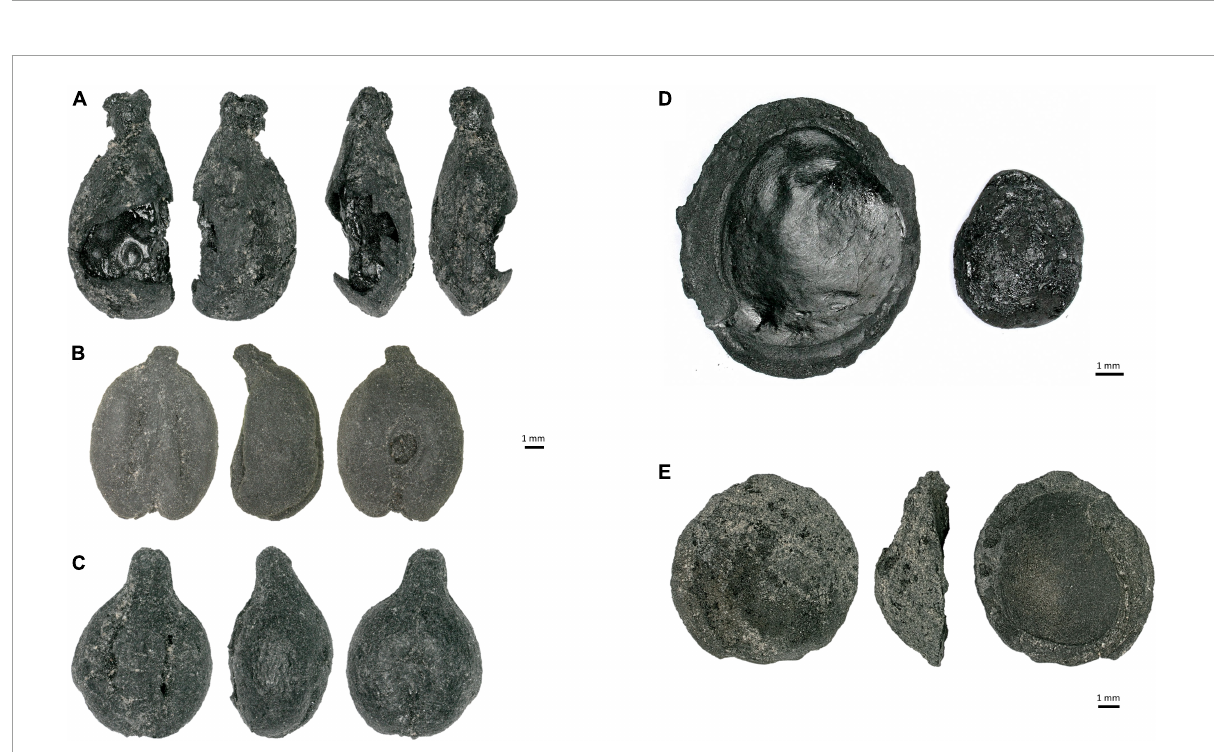
FIGURE6 Examples of fruit seed remains found in the assemblage: (A) Malus/Pyrus sp., (B,C) Vitis vinifera , and (D,E) Prunus sp.